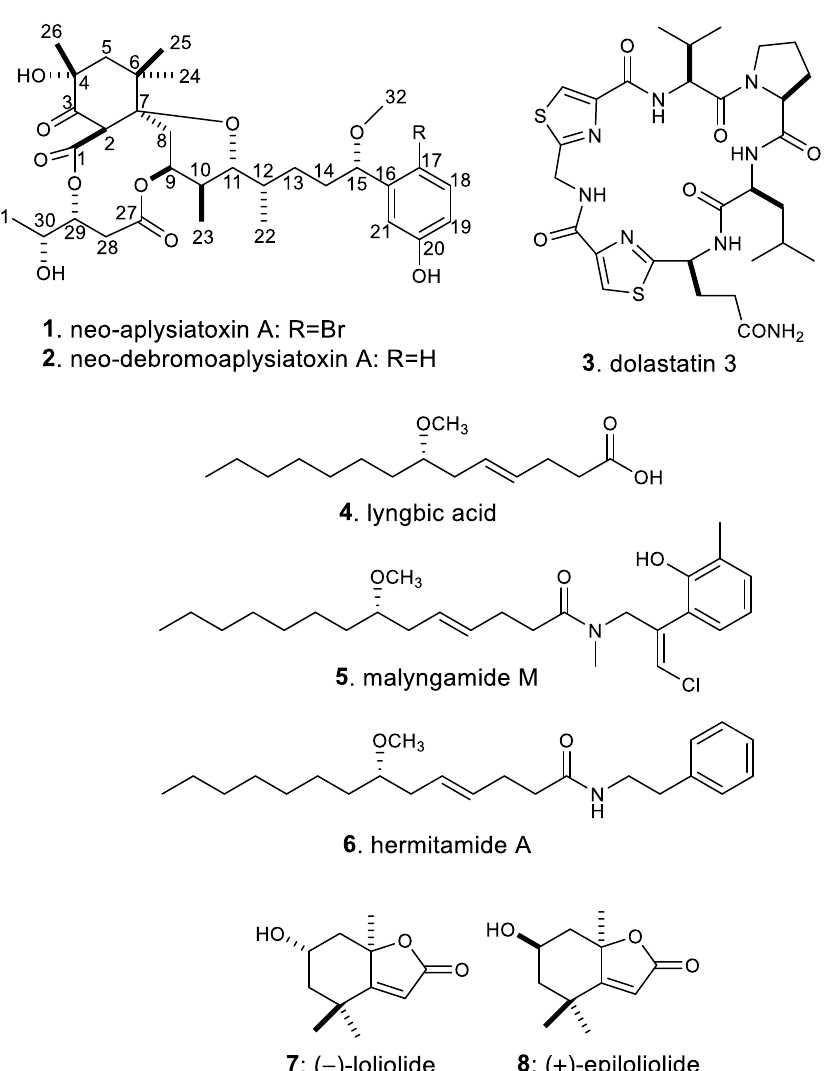
Figure 1. Structures of compounds 1 to 8 .